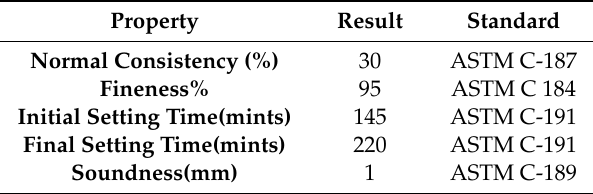
Table 1. Chemical properties of ordinary Portland Cement. Table 2. Physical properties of ordinary Portland Cement.